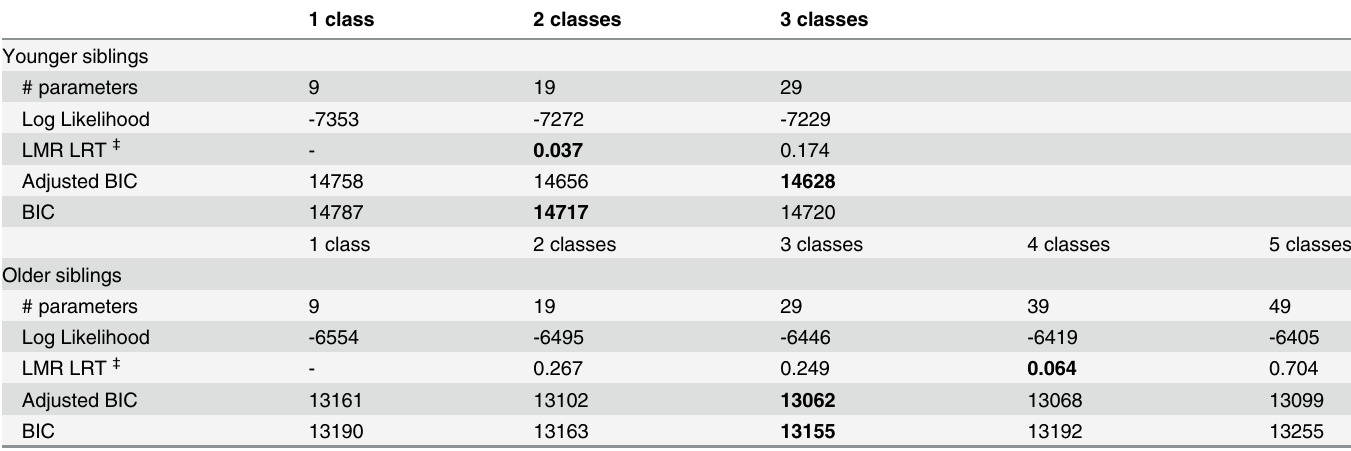
Table 1. Fit Indices for Younger and Older Siblings for 1 – 4 Class Models. †